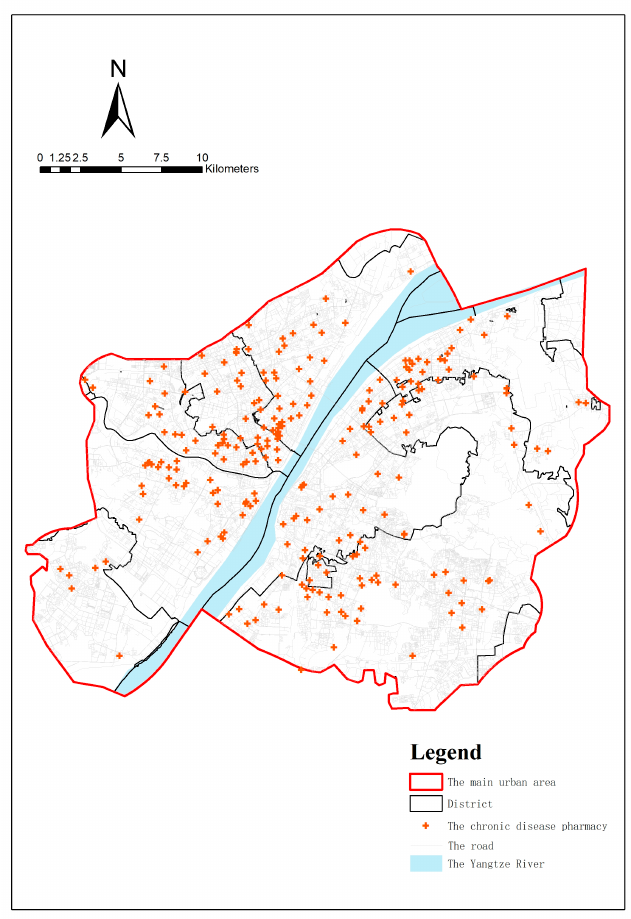
Figure 2. Distribution of chronic disease pharmacies and traffic road network in the main urban area of Wuhan.